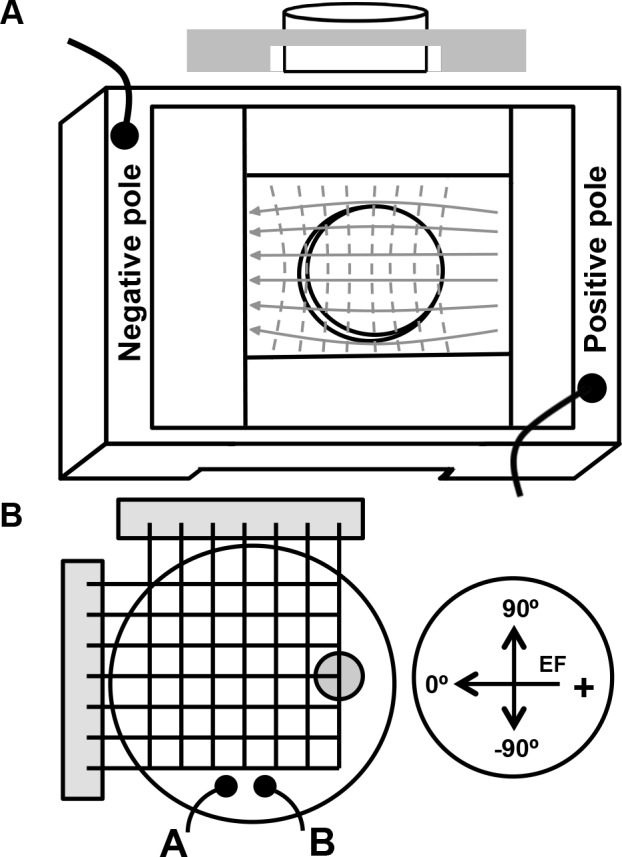
Apparatus for measuring C. elegans electrotaxis behavior.(A) A modified gel electrophoresis tank is used to generate a uniform electric field in an agar gel. The agar rests in a Plexiglas chamber with a channel that allows for the gel to be semi-submerged in a salt bath while the crawling surface remains above the liquid. The solid gray arrows represent the electric field direction created by applying a potential difference between the baths. (B) Applied electric field strength was determined by measuring voltage between two fixed platinum probes (A and B) spaced 10 mm apart in the direction of the field. The equivalent field strength of trajectory angle was determined by measuring the voltage difference at varying angles and distance from a single point (round circle). Angle coordinates were assigned -90 to 90°. The negative pole is designated 0°.